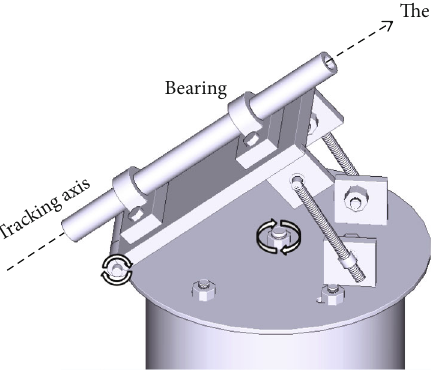
Figure 14: The tracking axis maintained with a mechanism.